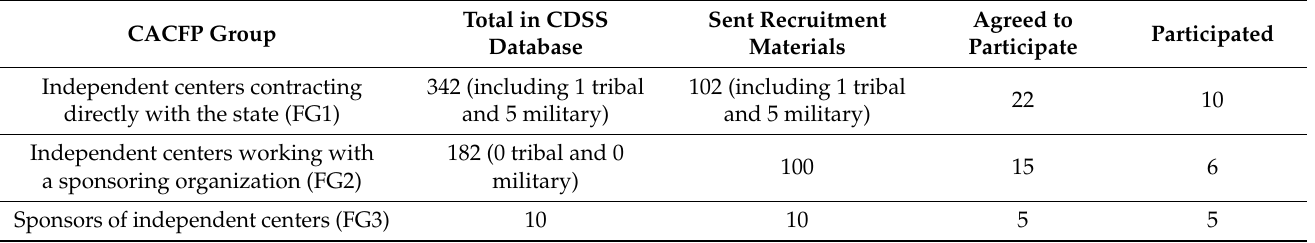
Child and Adult Care Food Program (CACFP) focus group recruitment sample and participation 1